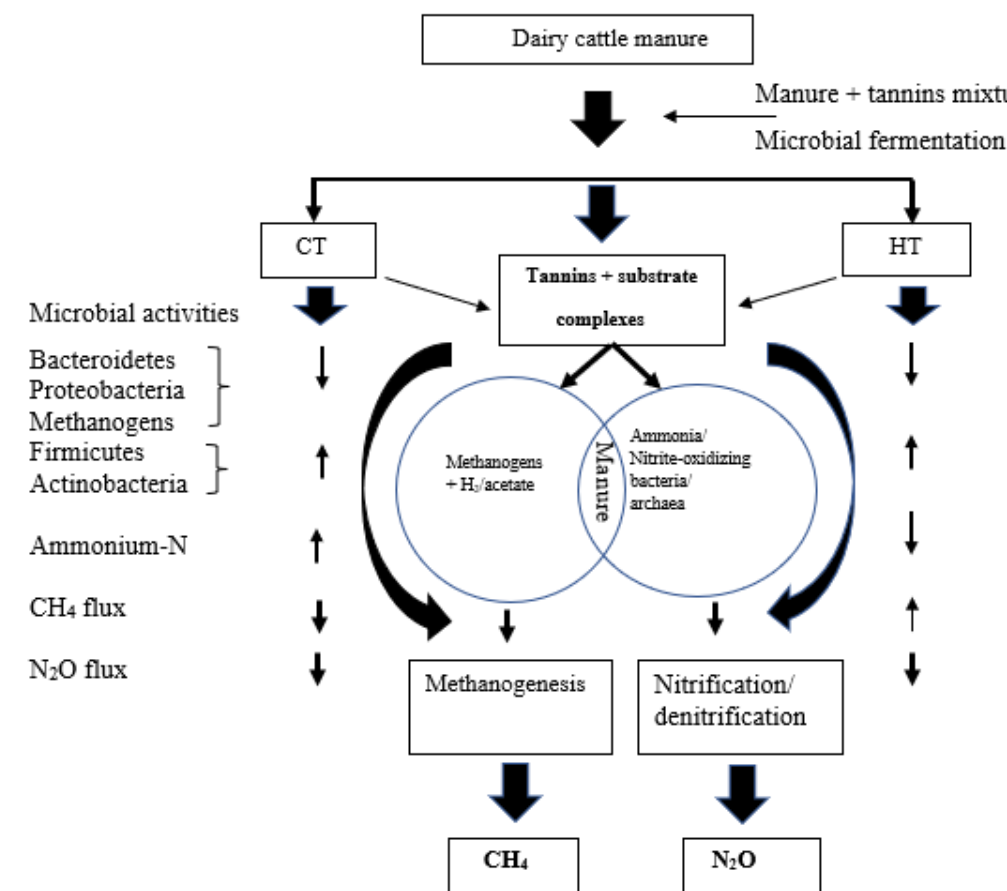
Figure 6. Proposed effect of condensed (CT) and hydrolyzable (HT) tannins on fecal bacteria and substrates and their interactions. Sources: current study; Barnard et al. [96]; Patra and Saxena [60]; C á ceres et al. [96]; and Min et al. [61]. Arrow bars represent the increase or decrease in microbial activities, ammonia-N, methane (CH 4 ), and nitrous oxide (N 2 O) flux associated with CT and HT.